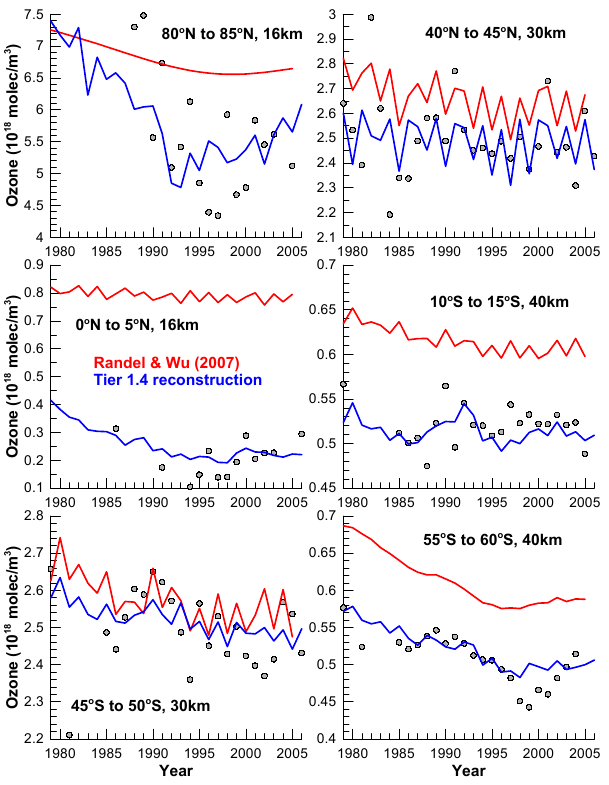
Figure 11. Selected March mean ozone time series from the Tier 0 database (grey dots), from Randel and Wu (2007) (red trace) and from the Tier 1.4 database (blue trace).